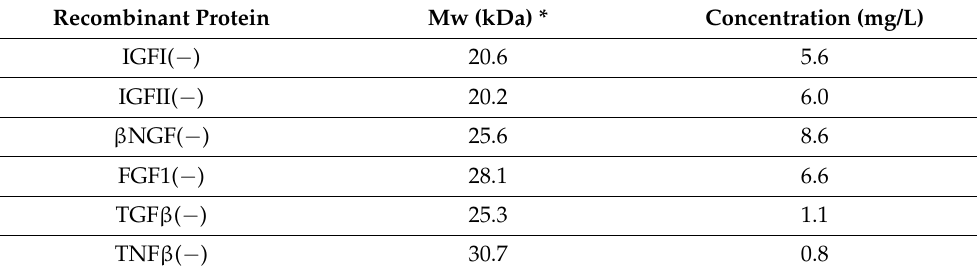
Table 2. The concentration of secreted recombinant protein.